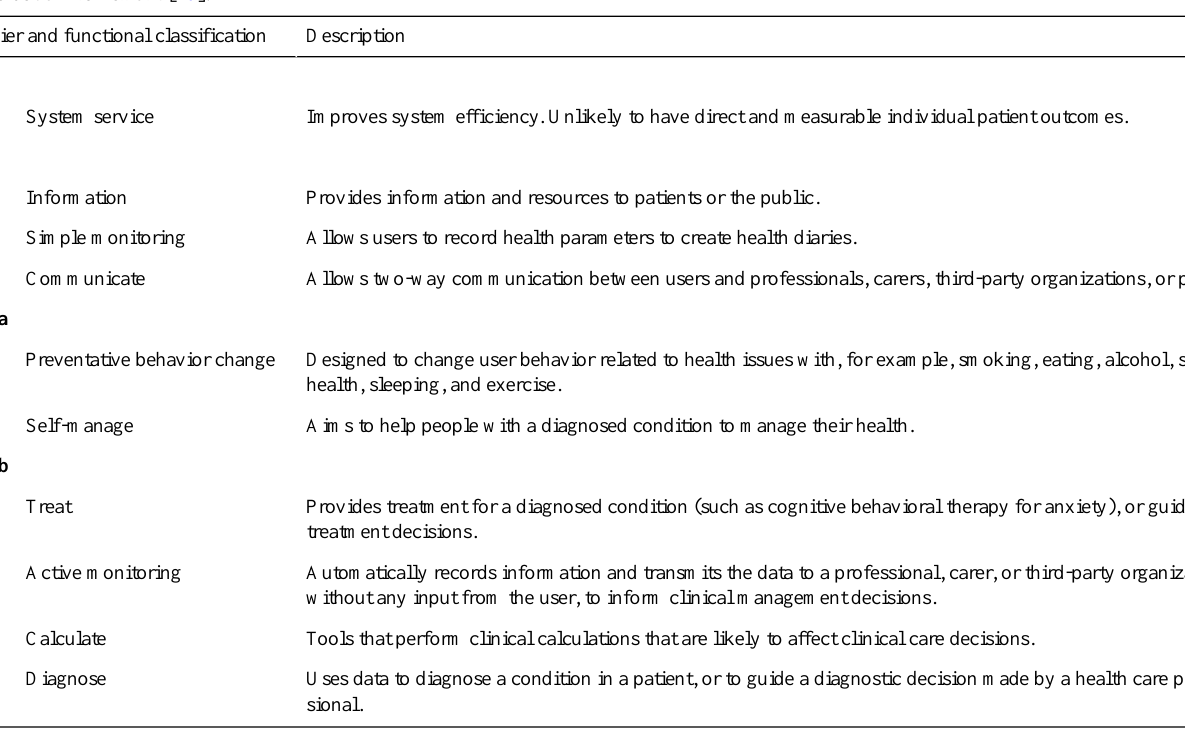
Table 1. Abridged definitions of digital health technology tiers from the National Institute for Health and Care Excellence (NICE) evidence standards evaluation framework [10].